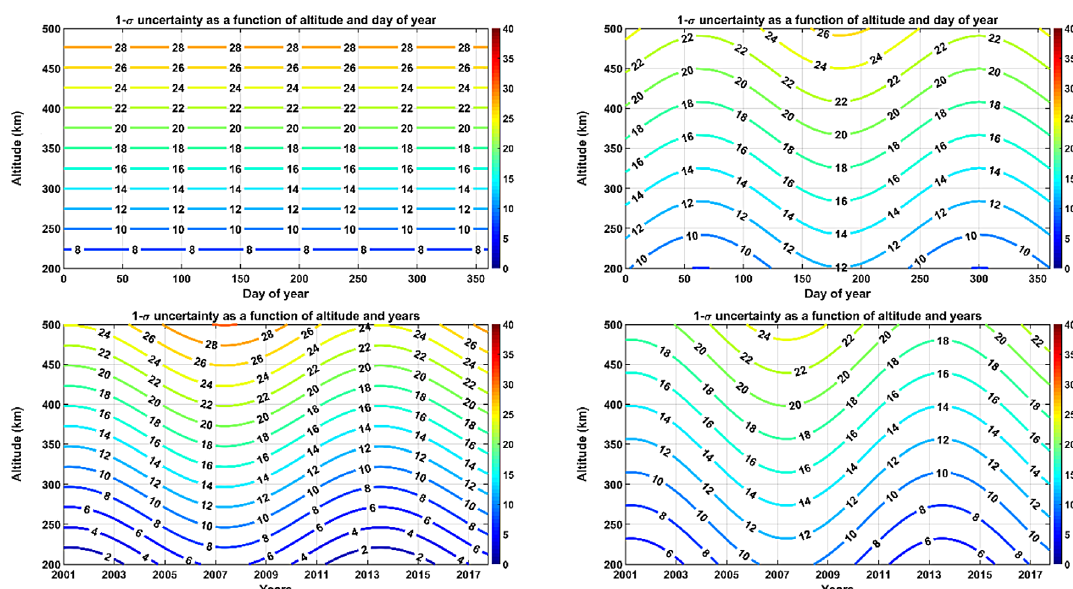
Fig. 12. Contour level plot of the 1- r uncertainty (in percent) as a function of temporal evolution: (left) Accelerometer uncertainty ’ s model, (right) HASDM uncertainty ’ s model. (top) altitude and day of year, (bottom) altitude and